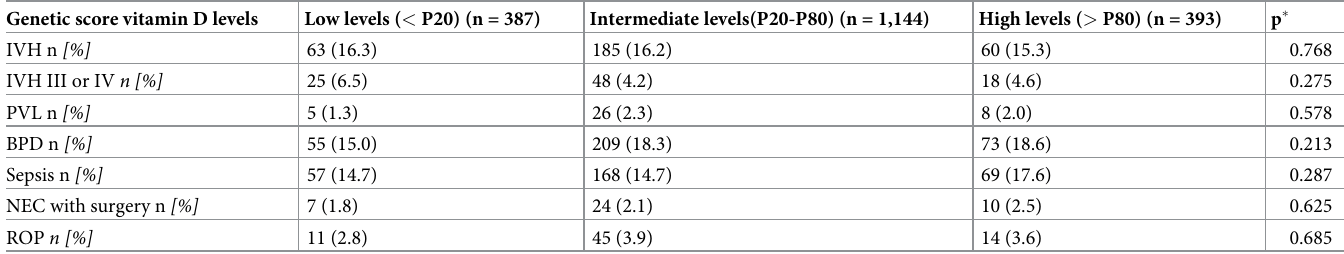
Table 2. Typical complications of preterm birth. Genetic score vitamin D levels